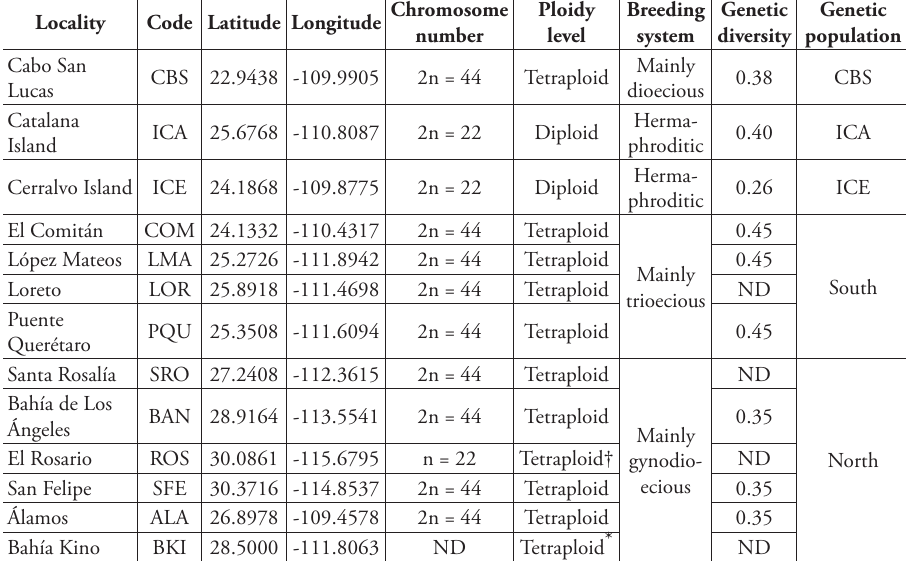
Table 1. Sample sites of the columnar cactus Pachycereus pringlei for which chromosome numbers were investigated, including counts by Pinkava et al. 1973 (†) and Murawski et al. 1994 (*). All diploid counts represent new reports for this species. Breeding systems, genetic diversity and genetic populations accord- ing to Gutiérrez-Flores et al. (2016). ND = not